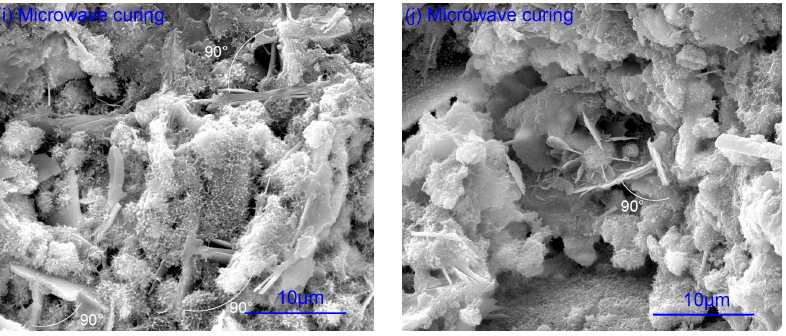
Figure 3. Fracture morphology of mortar prepared with composite binder containing 30 wt % glass powder at one day. ( a , b ) normal curing; ( c , d ) 40 °C steam curing; ( e , f ) 80 °C steam curing; ( g – j ) microwave curing.